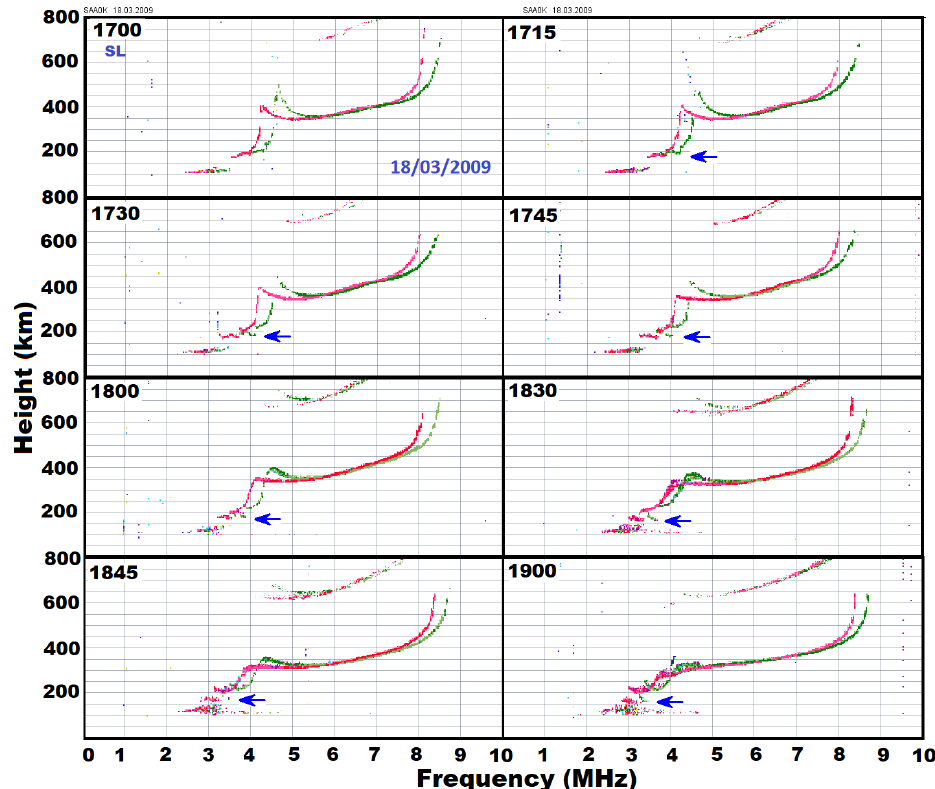
Figure 12. Sequence of ionograms from SL during 18 March 2009, showing the formation of an intermediate layer from a detachment of the F1 layer